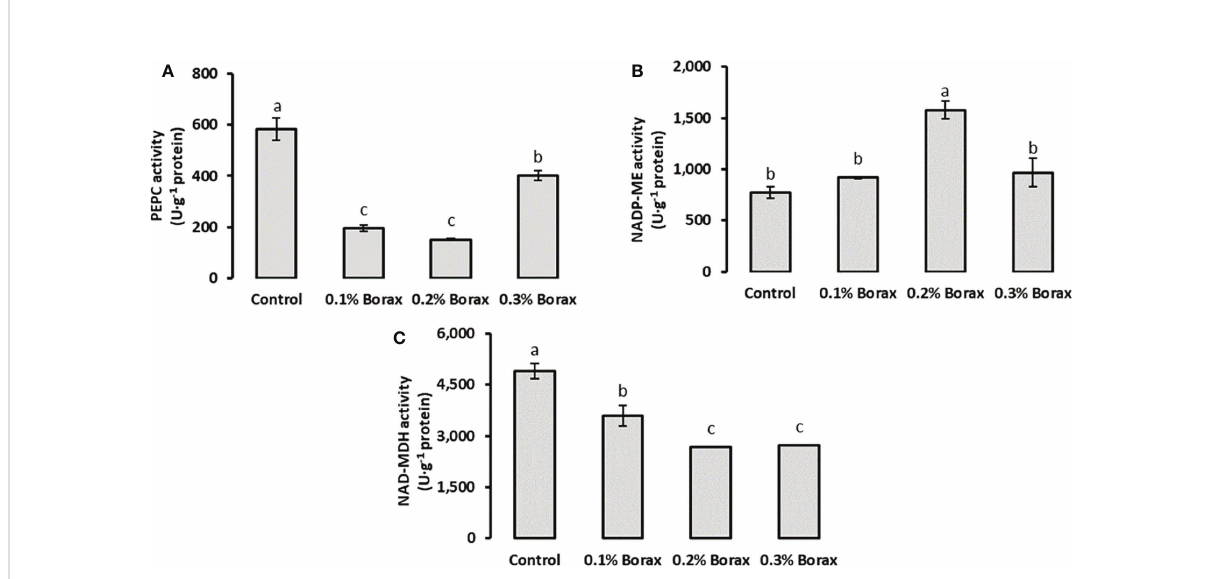
FIGURE 6 Effect of foliar application of B on the activities of key enzymes involved in malic acid metabolism i.e., PEPC (A) , NADP-ME (B) , and NAD-MDH (C) of loquat fruits. Same letters indicate non-signi fi cant difference among treatments according to Fisher ’ s least signi fi cant difference (LSD) test, when p ≤ 0.05 . Vertical bars indicate mean ± standard error (n=4, 4-block RCBD